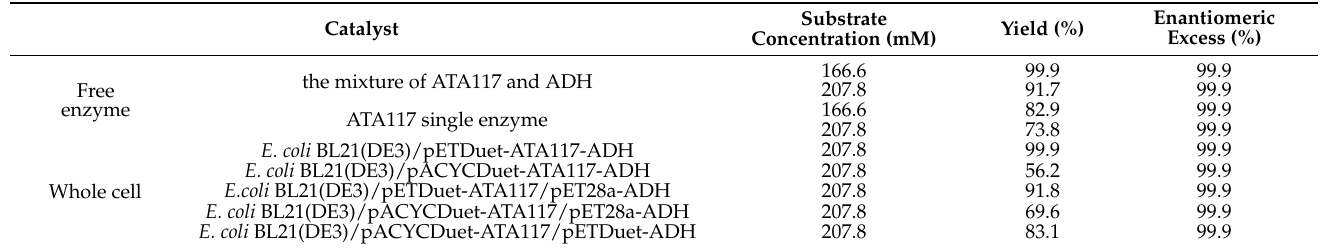
Table 4. Comparison of asymmetric synthesis of R-BPA catalyzed by free bienzyme and co-expression engineered